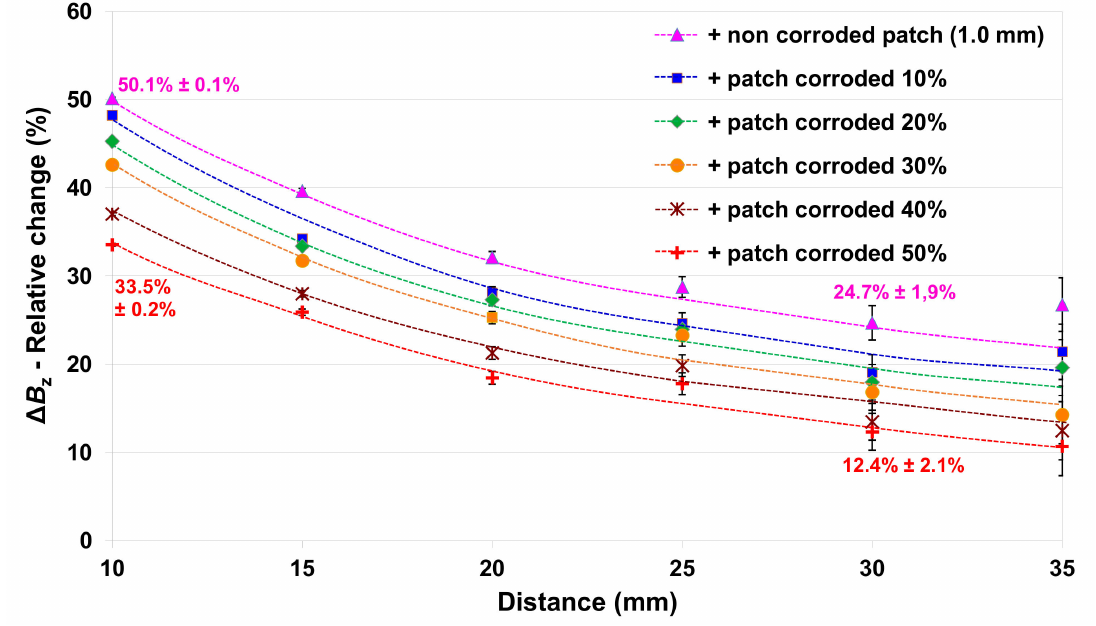
Figure 11. Relative change of B z as a function of distance for samples constituted with the 1.0 mm-thick